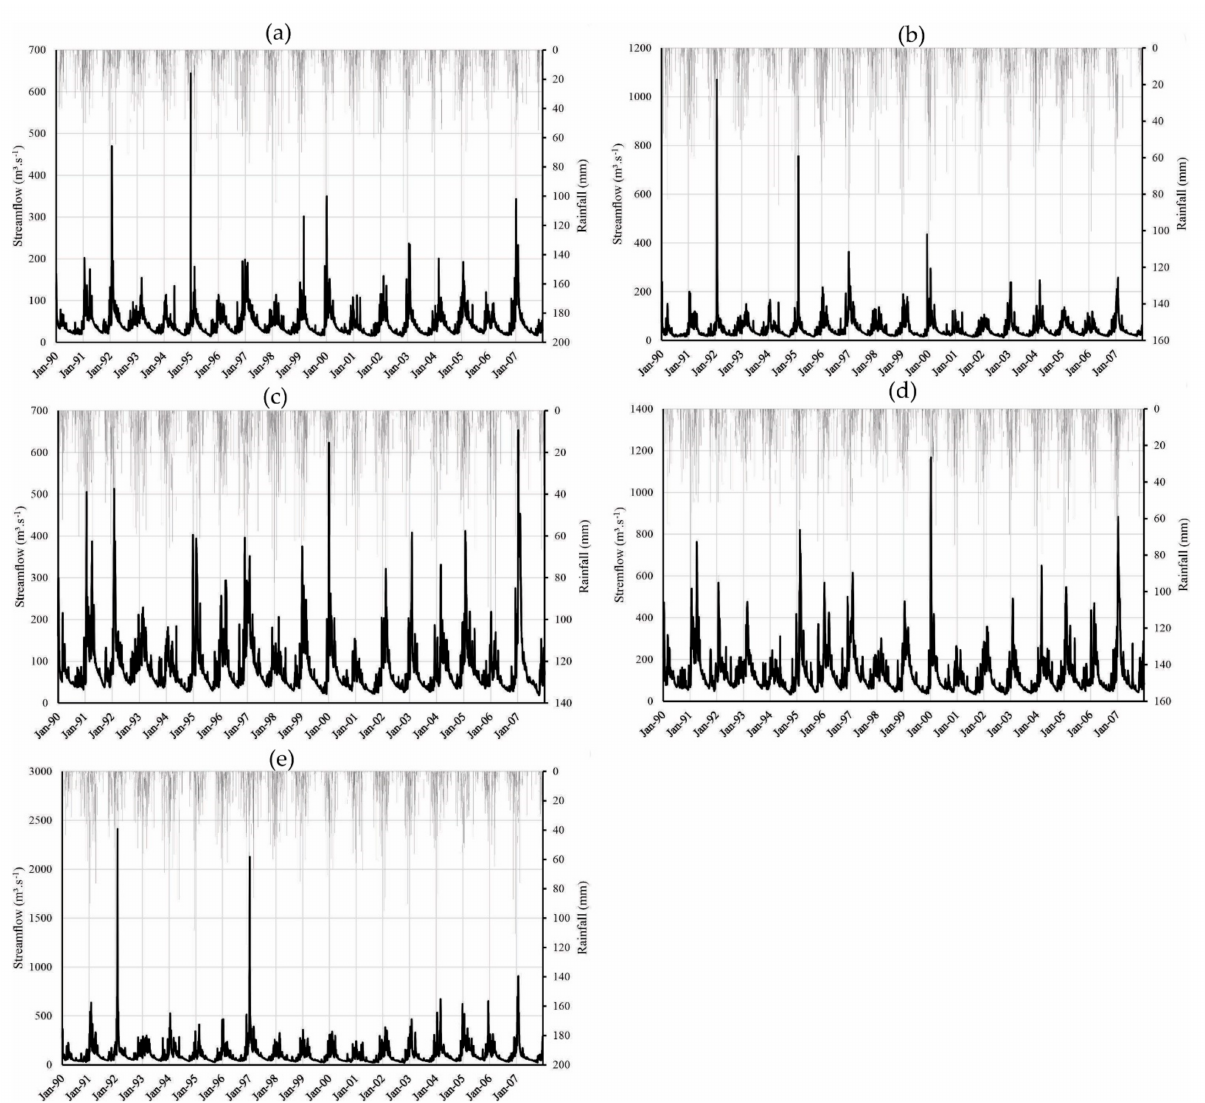
Figure 3. Observed hydrographs in the main sub-basins upstream of the Furnas reservoir: ( a ) Aiuruoca; ( b ) Grande; ( c ) Verde; ( d ) Sapuca í ; and ( e )